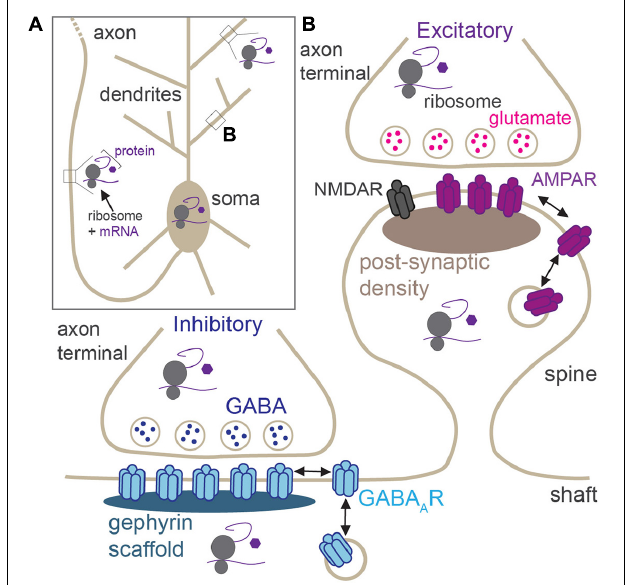
FIGURE 1 | Locations of activity-dependent translation in neurons. (A) Neurons have elaborate, long processes (dendrites and axons) which project from the soma. Translation of synaptic proteins takes place in the soma, proximal and distal dendrites, and within the axon. (B) Zoom of boxed region in panel (A) showing excitatory and inhibitory synapses. Excitatory synapses are housed in dendritic spines and contain post-synaptic glutamate receptors (AMPAR and NMDARs). GABAergic synapses are primarily located on dendritic shafts and contain synaptic GABA A Rs. Local activity-dependent translation supports synaptic plasticity at both synapses in pre- and post-synaptic